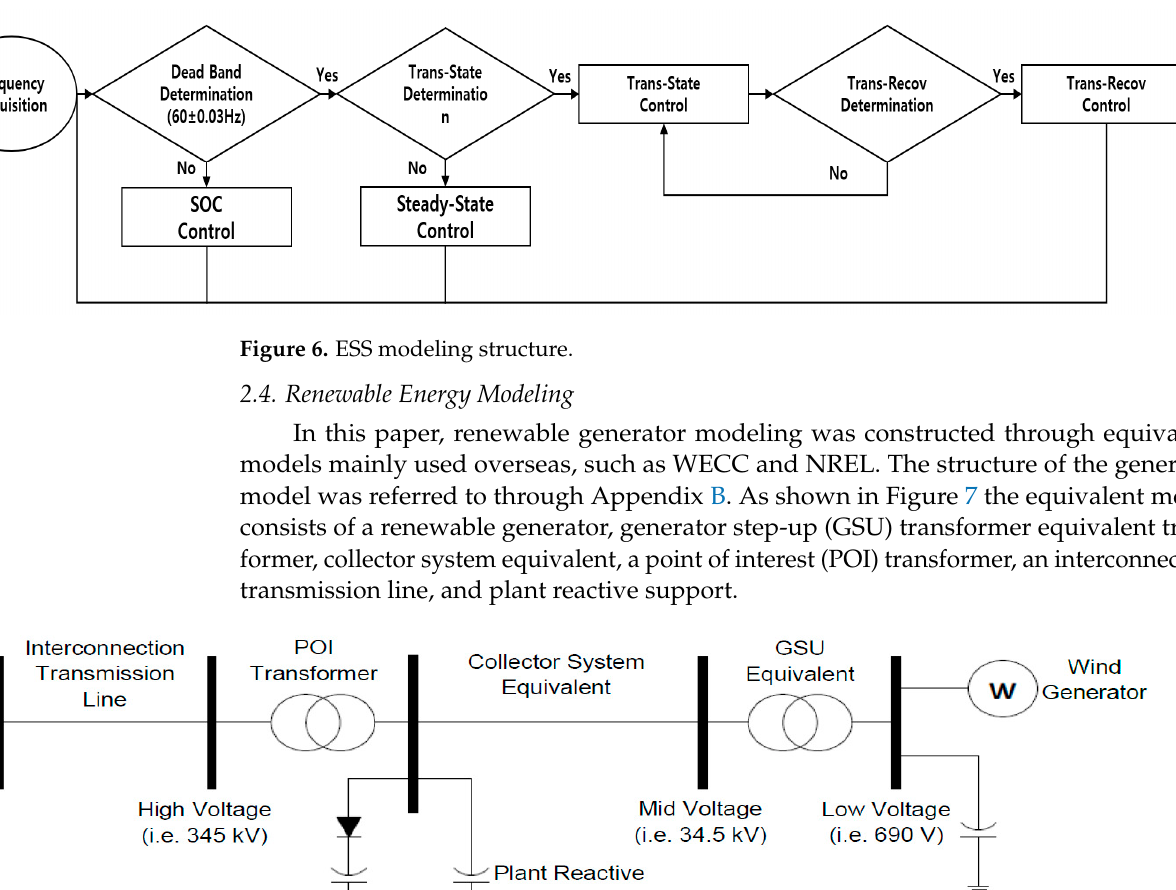
( b ) Figure 8. Output characteristics by the HVDC model: ( a ) UDM HVDC Output characteristics and ( b ) VSC HVDC Output characteristics. When comparing UDM HVDC modeling and VSC modeling, the lowest frequency of the UDM HVDC model was high, and there was a difference in the frequency wave- form characteristics during the frequency recovery process.